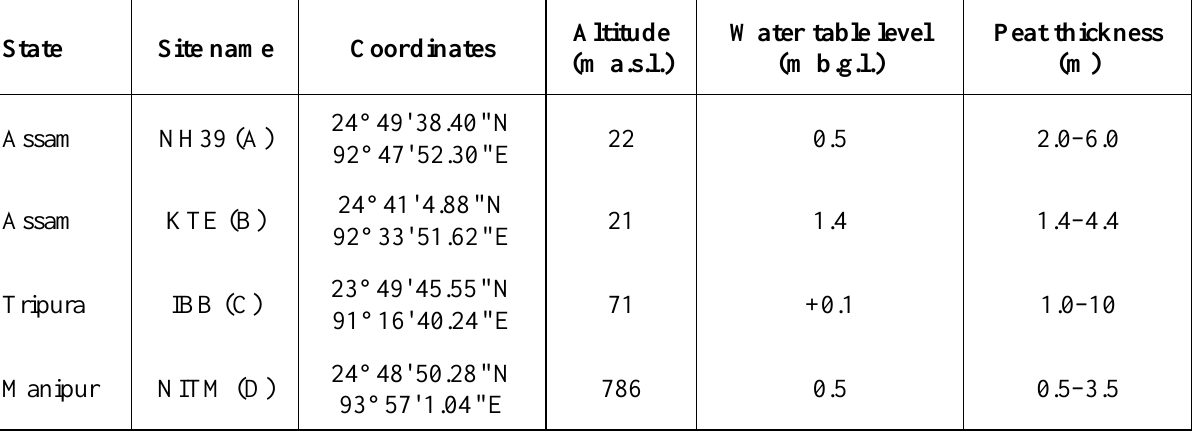
Table 1. General characteristics of the study sites. m a.s.l = metres above sea level; m b.g.l = metres below ground